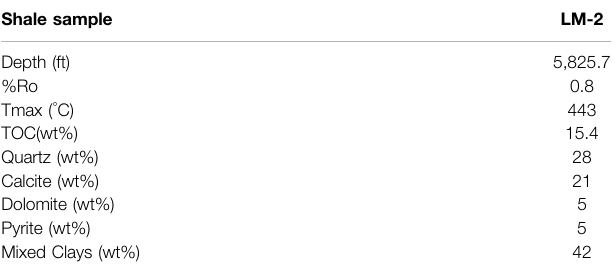
TABLE 1 | LM-2 shale depth, thermal maturity, organic content and mineral composition. Error is ± 1% (Pilewski et al., 2019). Shale sample